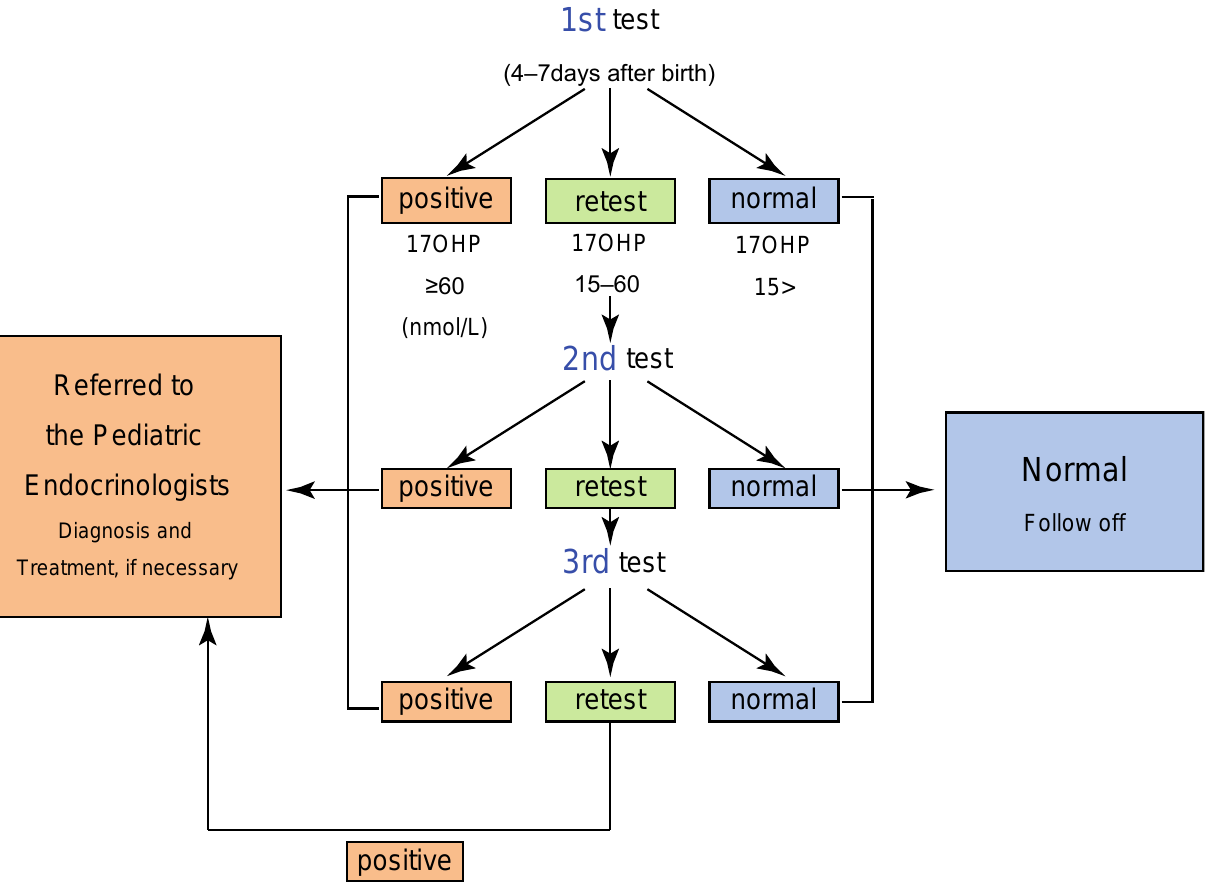
Figure 2. Algorithm of CAH screening in Tokyo.